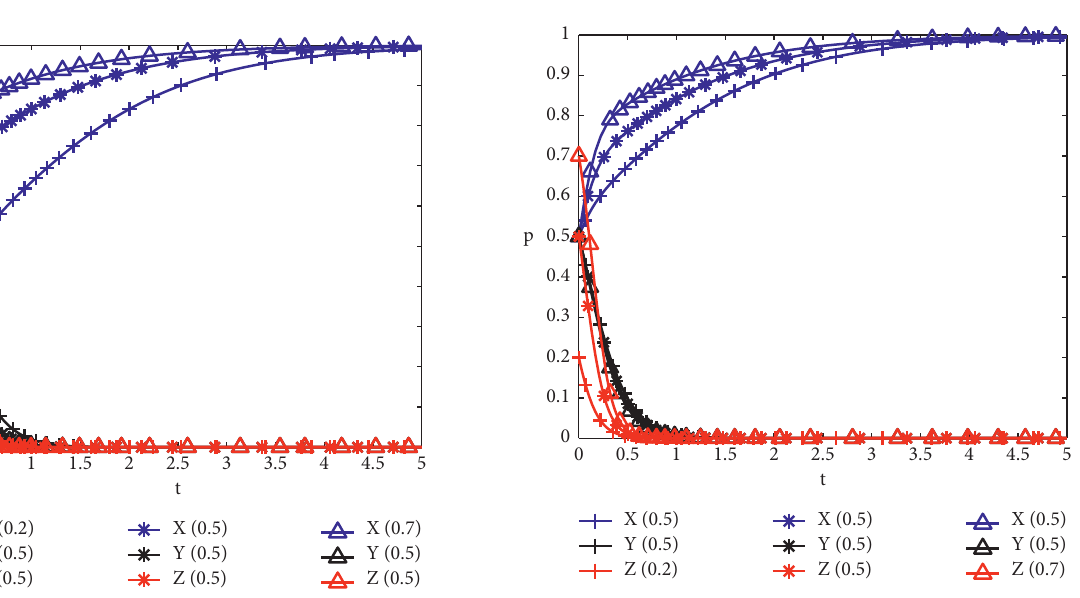
Figure 5: The evolution result of the change of social organizations’ initial strategies.